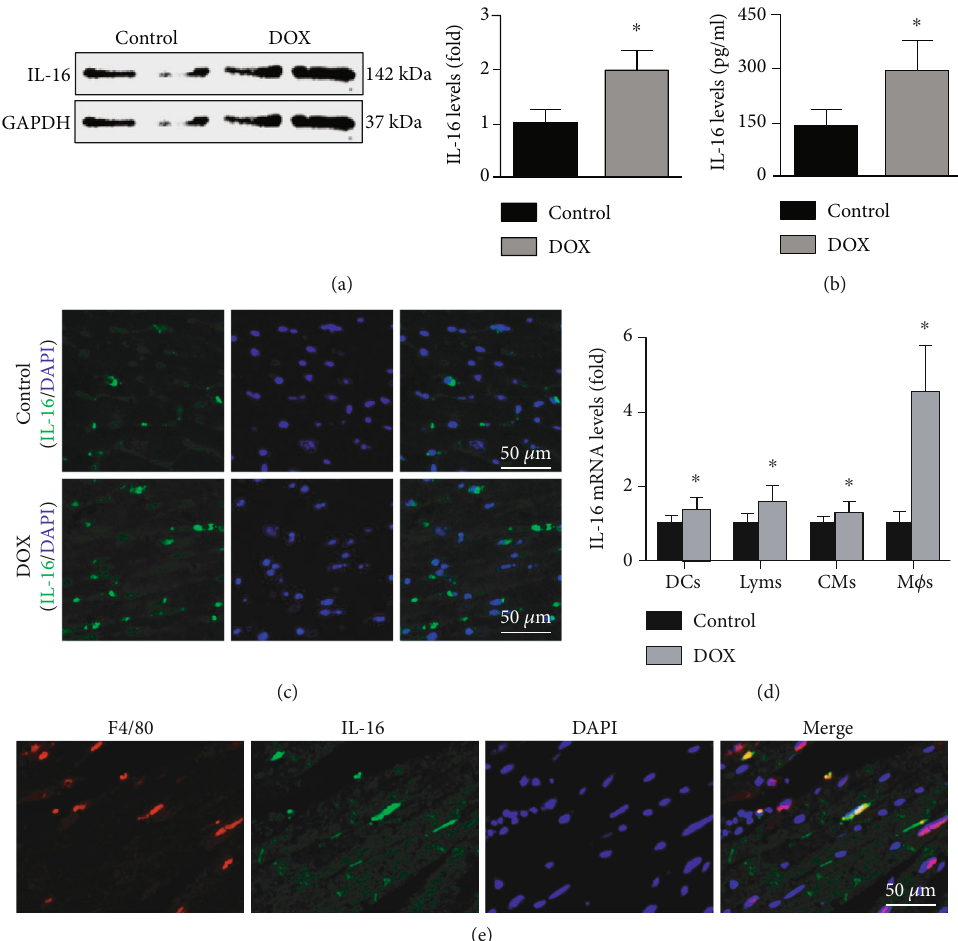
Figure 1: E ff ects of DOX on cardiac IL-16 expression. (a, b) Cardiac IL-16 expression and serum IL-16 levels were measured in the control and DOX groups (nonparametric test). (c) Cardiac IL-16 expression in the 2 groups was determined by immuno fl uorescence staining (200x). (d) E ff ects of DOX on IL-16 mRNA expression in CTLL-2 T lymphocytes (Lyms), RAW264.7 macrophages (Møs), DC2.4 dendritic cells (DCs), and HL-1 cardiomyocytes (CMs) (Student ’ s t -test). (e) Double immuno fl uorescence staining with anti-F4/80 and anti-IL-16 in DOX-induced mice (200x). N = 5 in each group. ∗ p < 0 : 05 vs. the control